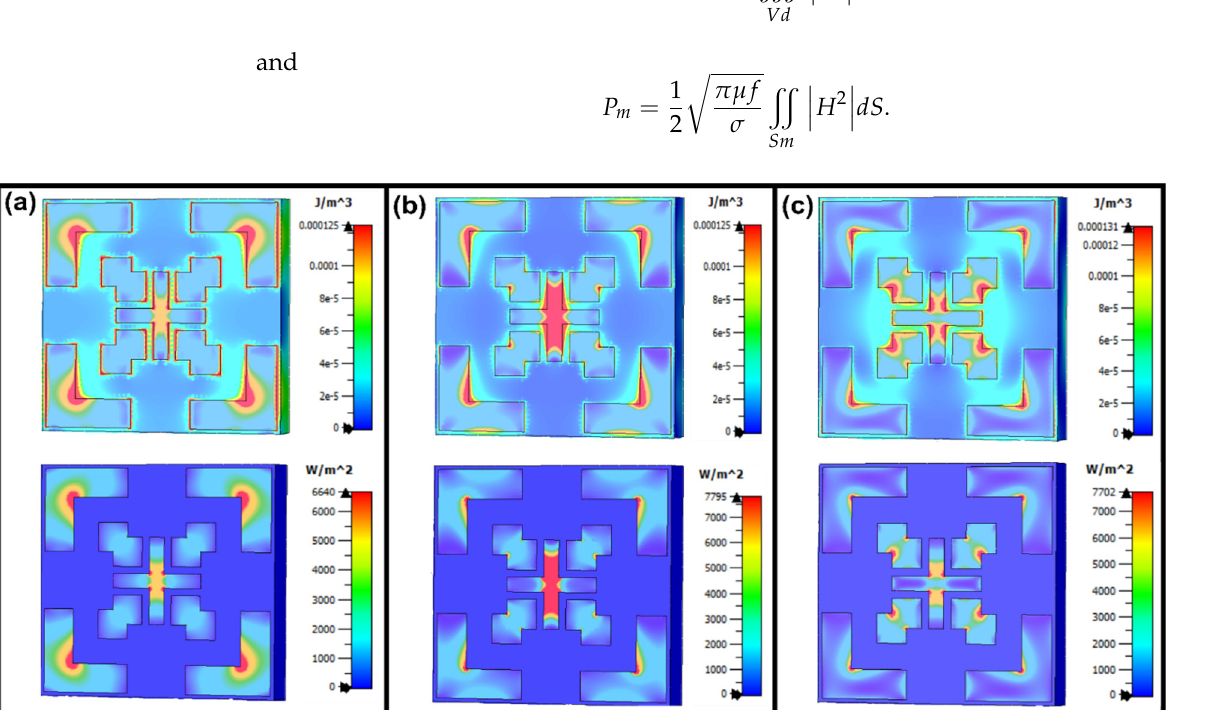
Figure 3. Three-dimensional distribution of the magnetic-energy density in the dielectric layer ( top ) and the surface